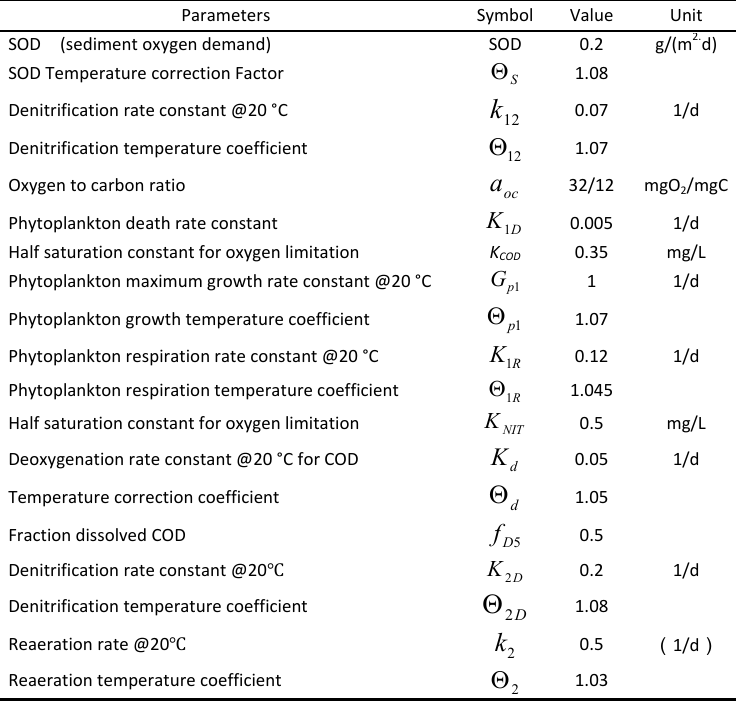
Table 4: WASP model parameters for Ashi River (Li et al. , 2016) Table 4 : WASP model parameters for Ashi River (Li et al. , 2016)